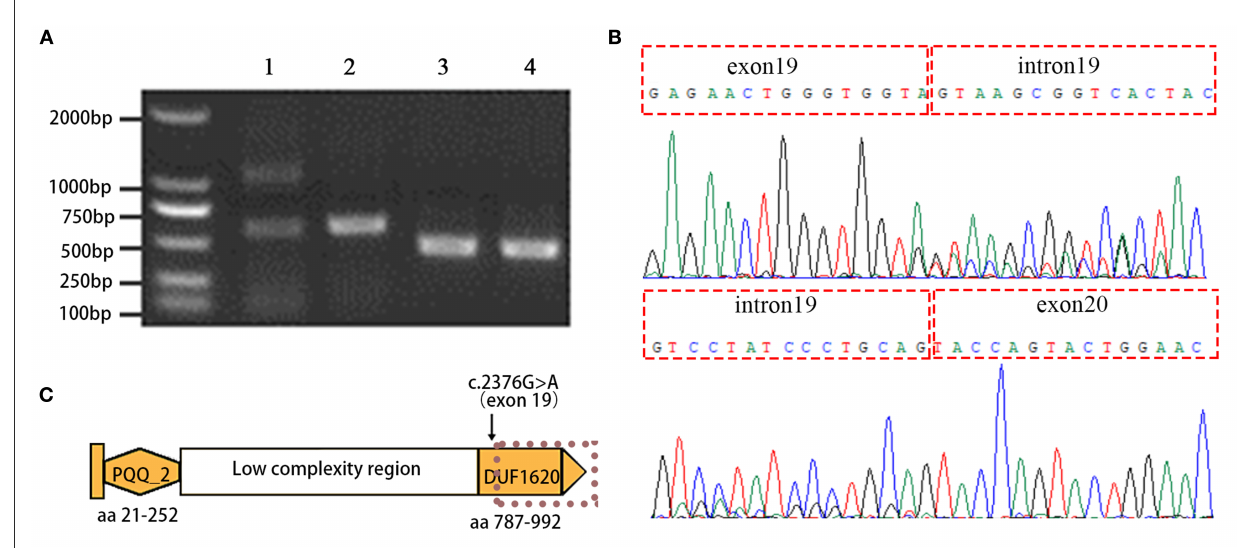
FIGURE3 Aberrant splicing of the EMC1 c.2376G > A variant is detected by using RT-PCR and Sanger sequencing. (A) Agarose gel electrophoresis image shows the RT-PCR products amplified by the primers spanning EMC1 exons 18-22 with inclusion of the c.2376G > A mutation site in exon 19 (lane 1, the proband; lane 2 healthy control), and the primers targeting the upstream and downstream sequences of the c.765_c.777delinsATTCTACTT mutation (lane 3, the proband; lane 4 healthy control). (B) Sanger sequencing reveals the aberrant retention of intron 19 between exon19 and exon 20 in EMC1 mRNA. (C) Schematic representation of the domains of EMC1. PQQ_2 represents the quinoprotein alcohol dehydrogenase-like domain and DUF1620 represents the uncharacterized domain of unknown function 1620. The dotted line indicates premature truncation of the protein due to the aberrant mRNA resulting from the c.2376G > A